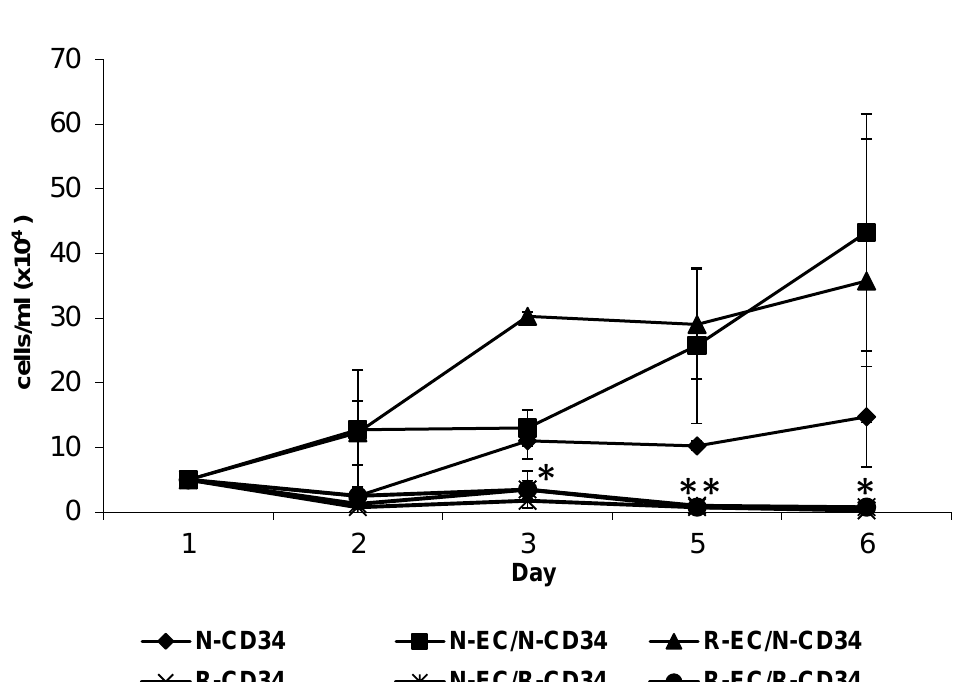
Figure 6. hBMEC improved HSPC proliferation. CD34 + HSPC or EC were irradiated (4 Gy MF) and cocultured overnight. N = nonirradiated; R = irradiated. CD34 + HSPC were counted using trypan blue exclusion. Significance was determined with samples compared to N-CD34 + cells. Error bars represent standard deviation. * p < 0.05. ** p < 0.005.